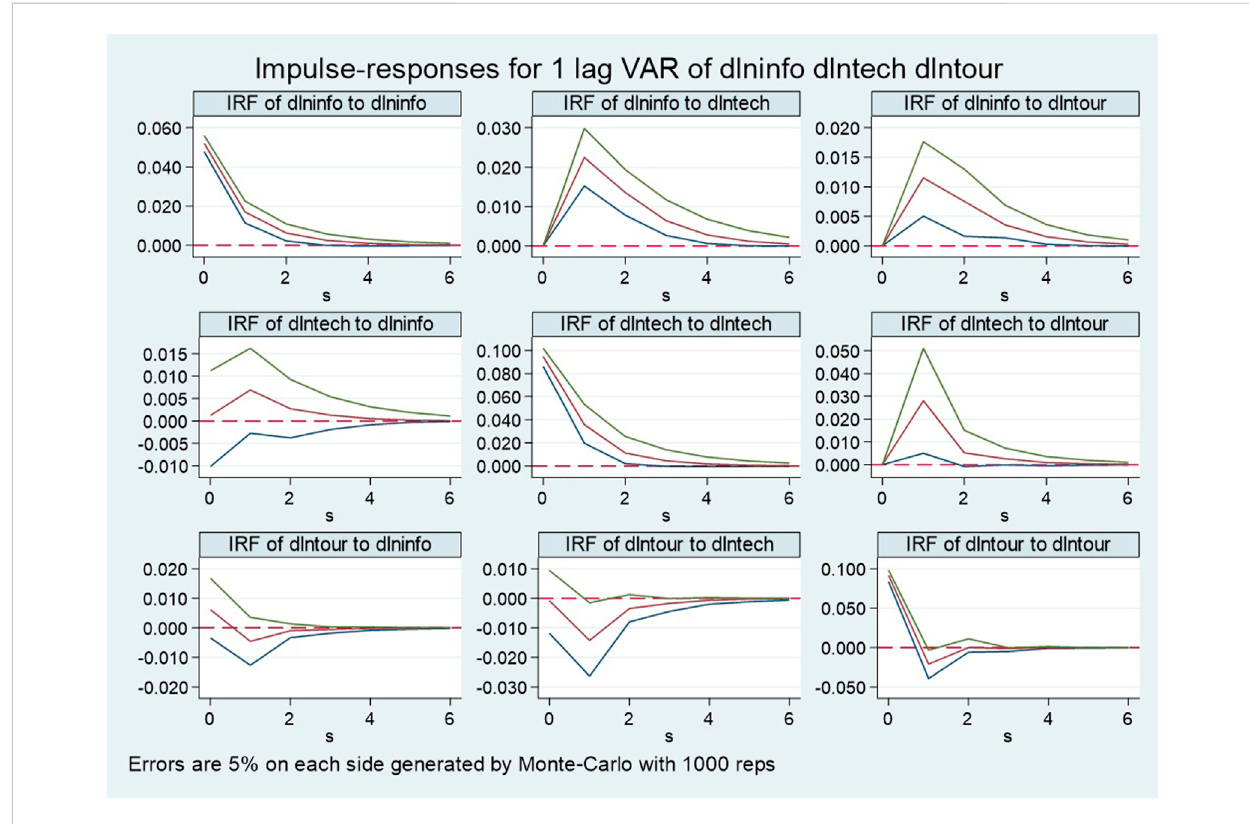
FIGURE 2 Pulse response of tourism industry, technological innovation, and informatization of China (Note: the red lines represent estimated pulse response value. The area between the green lines and blue lines is the con fi dence interval of 5% signi fi cance so the green lines are upper limits value and the blue lines are lower limits